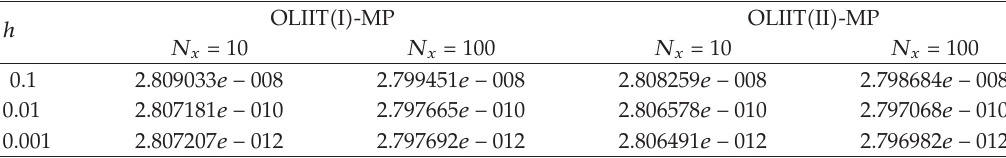
Table 5: The errors (cid:16) at t (cid:5) 10 when the algorithms are applied to the problem (cid:3) 5.6 (cid:4) with the coe ffi cients group I, where τ (cid:3) t (cid:4) (cid:5) sin t (cid:8) 1.